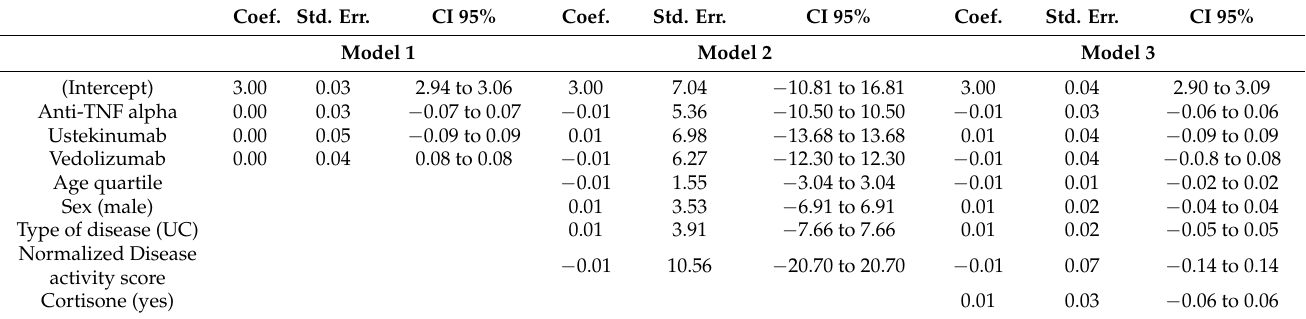
Table 4. Rank-based estimation regression on T0 S1/S2 IgG SARS-CoV-2.